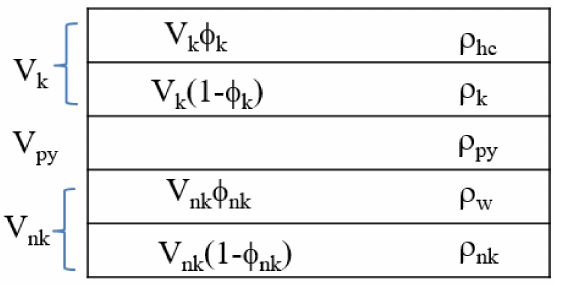
Figure 6. Petrophysical model of the shale